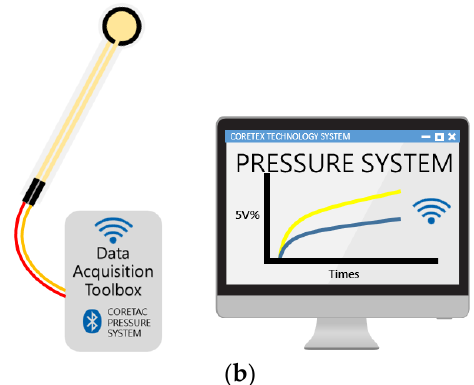
Figure 5. The completed structure of the smart tool holder: ( a ) Part 1 is the front cover; ( b ) part 2 is the rear cover; ( c ) parts 3 to 5 form the wedge through which the smart tool holder is installed on the turret; ( d ) the smart tool holder clamping the turning tool; and ( e ) the assembly of the smart tool holder and turning tool installed on the turret through the wedge.